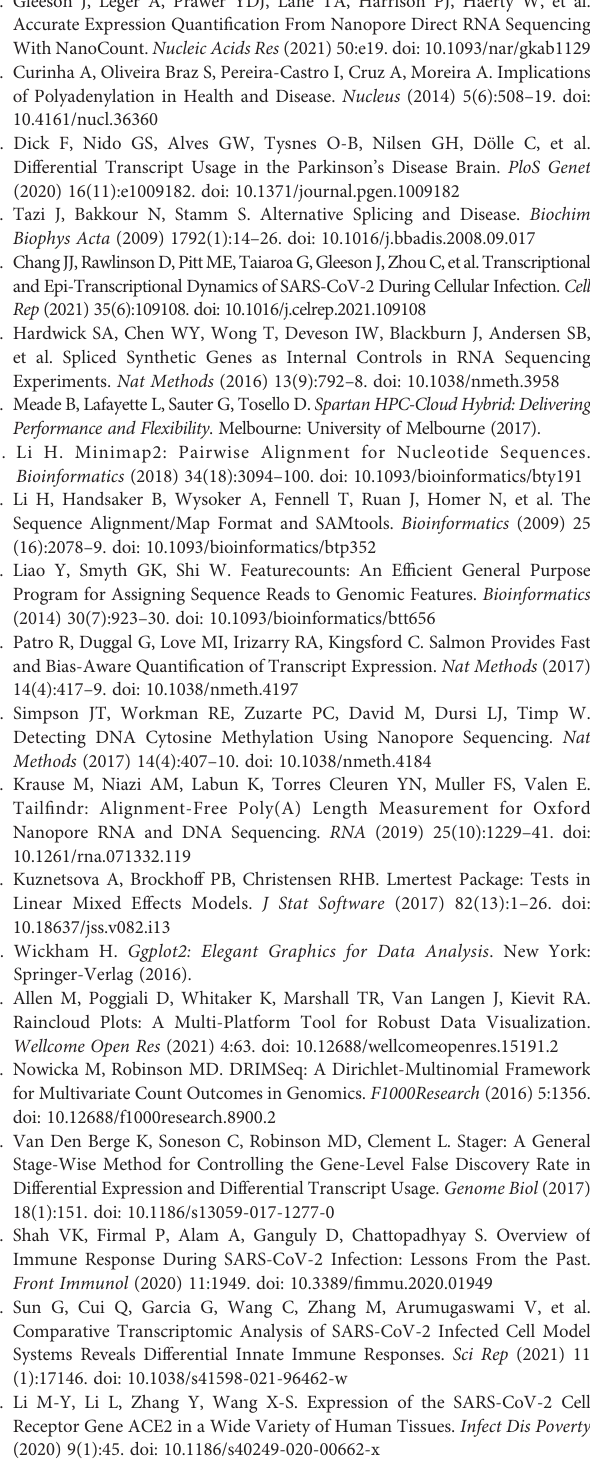
Supplementary Table 2 | Comparison of signi fi cantly differentially polyadenylated non-mitochondrial gene clusters in the Calu-3 48 hpi datasets between nanopolish, tail fi ndr poly(A) and poly(T) outputs (before log-transformation) using Wilcoxon ’ s test of ranks. nanopolish and tail fi ndr poly(T) results were more